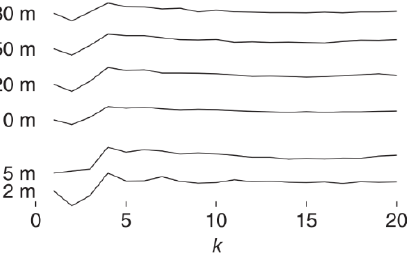
Figure 20. Variation of normalized BIC value with number of clusters when M2 meridional and zonal winds are grouped into k clusters at each height [18].